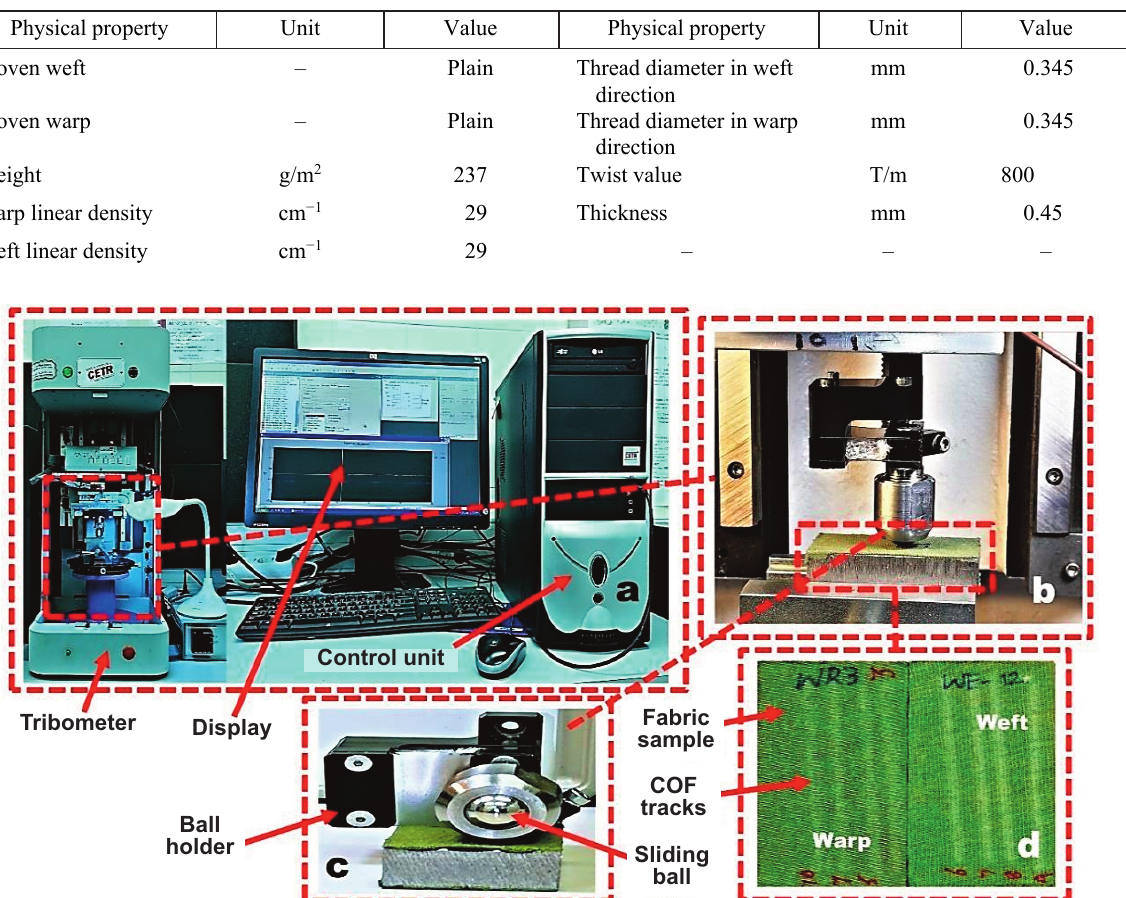
Table 1. Subjective assessment of post-consumer cotton textile